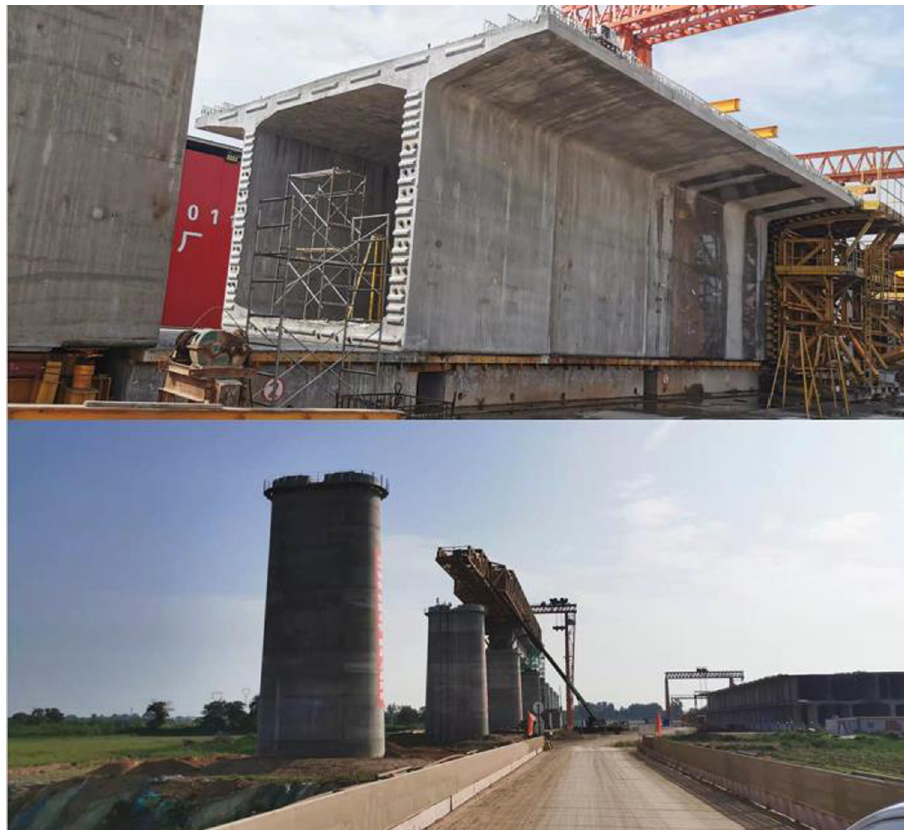
Figure 11: The piers and